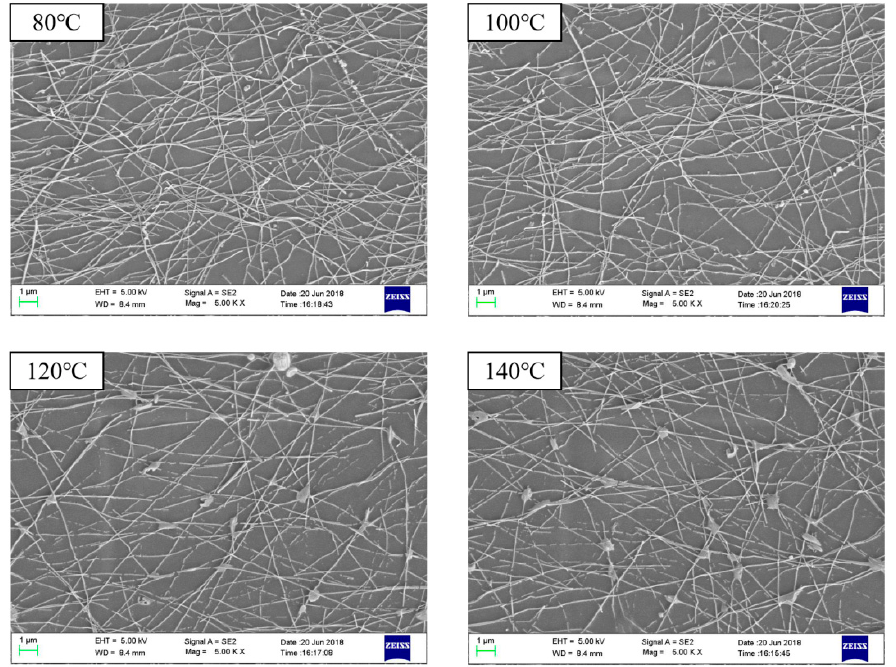
Figure 6. SEM images of the AgNWs patterns at different treatment temperatures.